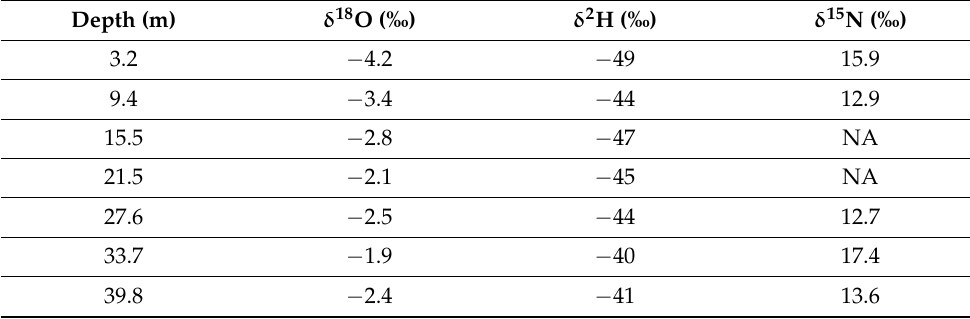
Table 4. Borehole 7 (53-20824) stable isotope